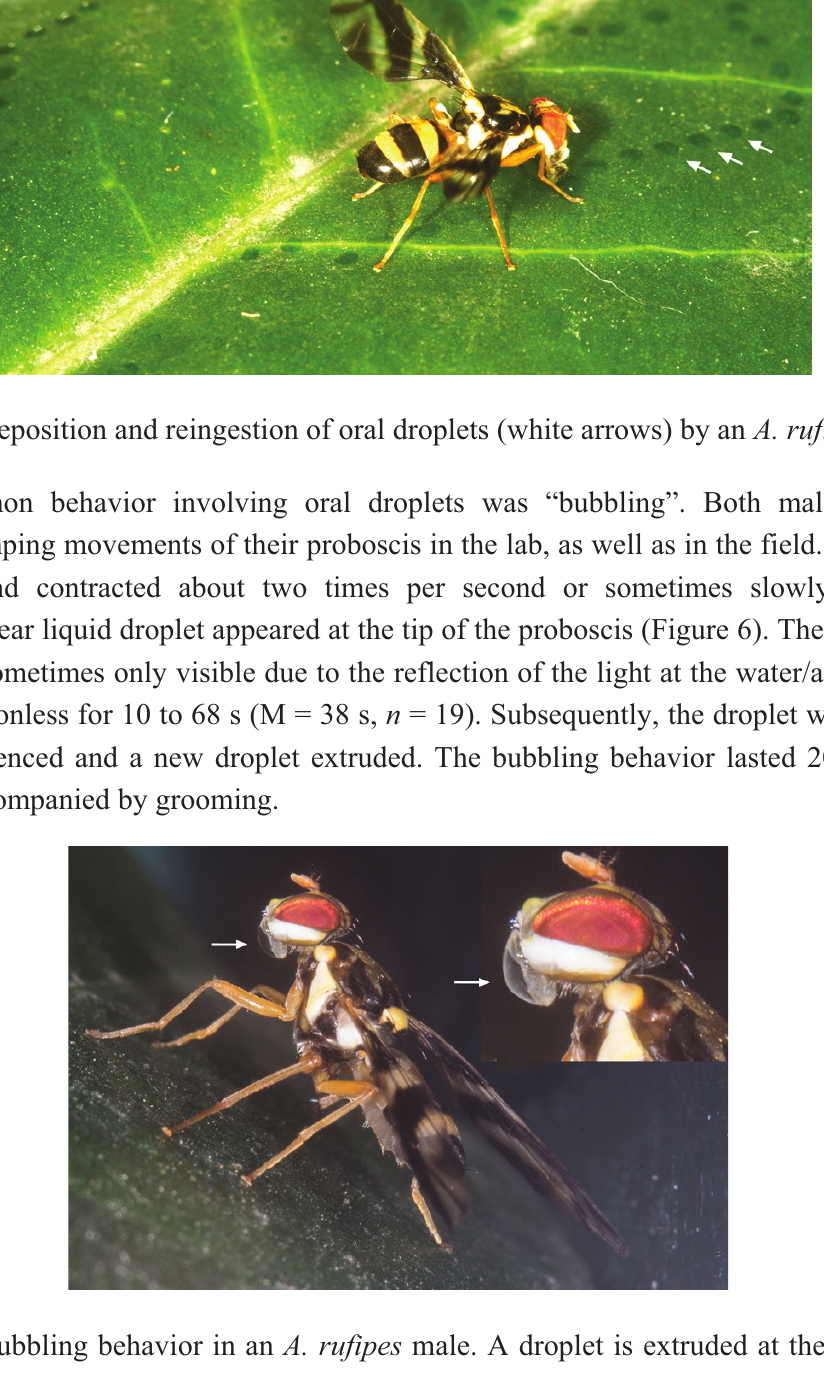
Figure 6. Bubbling behavior in an A. rufipes male. A droplet is extruded at the tip of the proboscis (arrow). The inset shows the enlarged